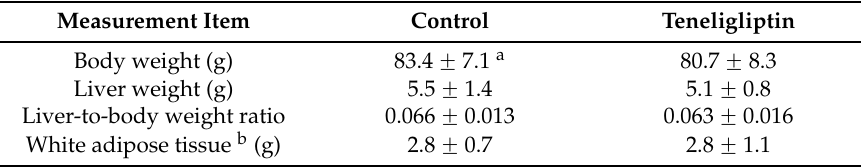
Table 1. Body, liver and fat weights of the experimental mice.